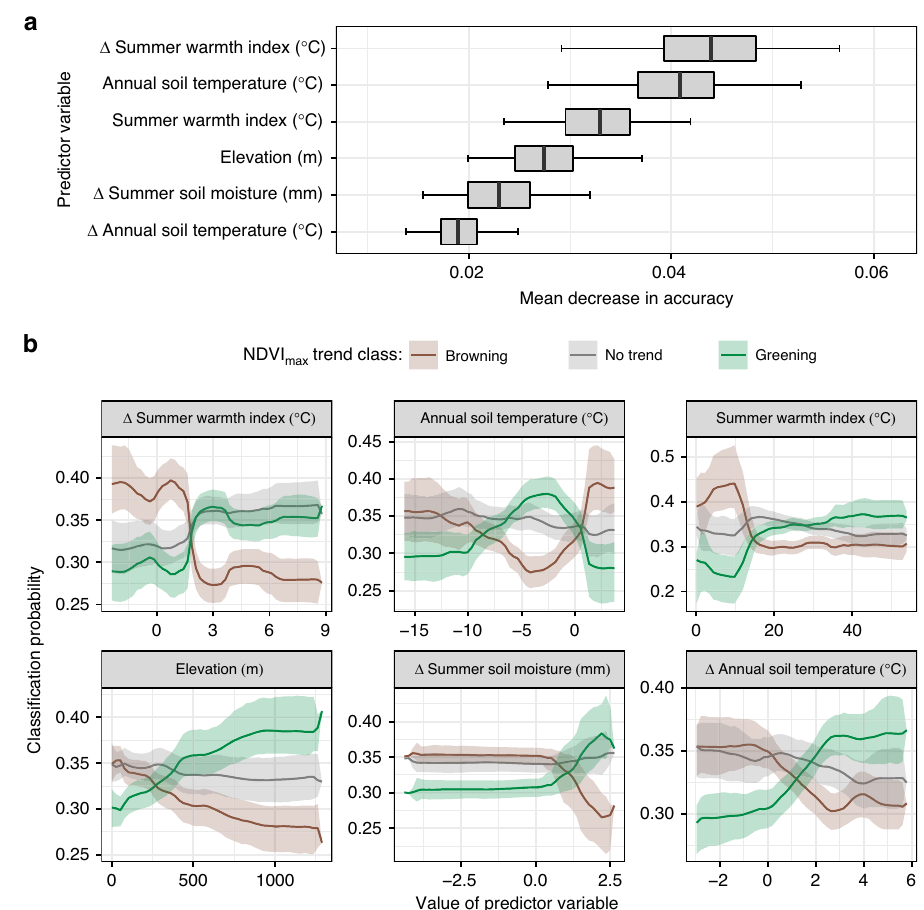
Fig. 5 Primary environmental predictors of tundra greenness trends. Variable importance and partial dependence of the six most important variables for predicting site-level Landsat NDVI max trend categories from 2000 to 2016 using Random Forests. The three NDVI max trend categories included browning, no trend, and greening that were based on trend direction and signi fi cance ( α = 0.10). a Variable importance was characterized by the mean decrease in accuracy, where a higher value indicates that a variable is more important to the classi fi cation. b Partial dependency plots illustrate how each predictor variable affects class probability while accounting for the mean effect of other predictors in the model. The top six predictor variables included changes ( Δ ) in summer warmth index (2000 – 2016), summer soil moisture (2000 – 2016), and annual mean soil temperature (2003 – 2016), as well as elevation, summer warmth index in 2000, and annual mean soil temperature in 2003. Soil temperature data were for 1 m depth and were not available prior to 2003. Boxplot lines and whiskers in a depict median estimates and 95% con fi dence intervals derived from Monte Carlo simulations ( n = 10 3 ), as do solid lines and error bands in b